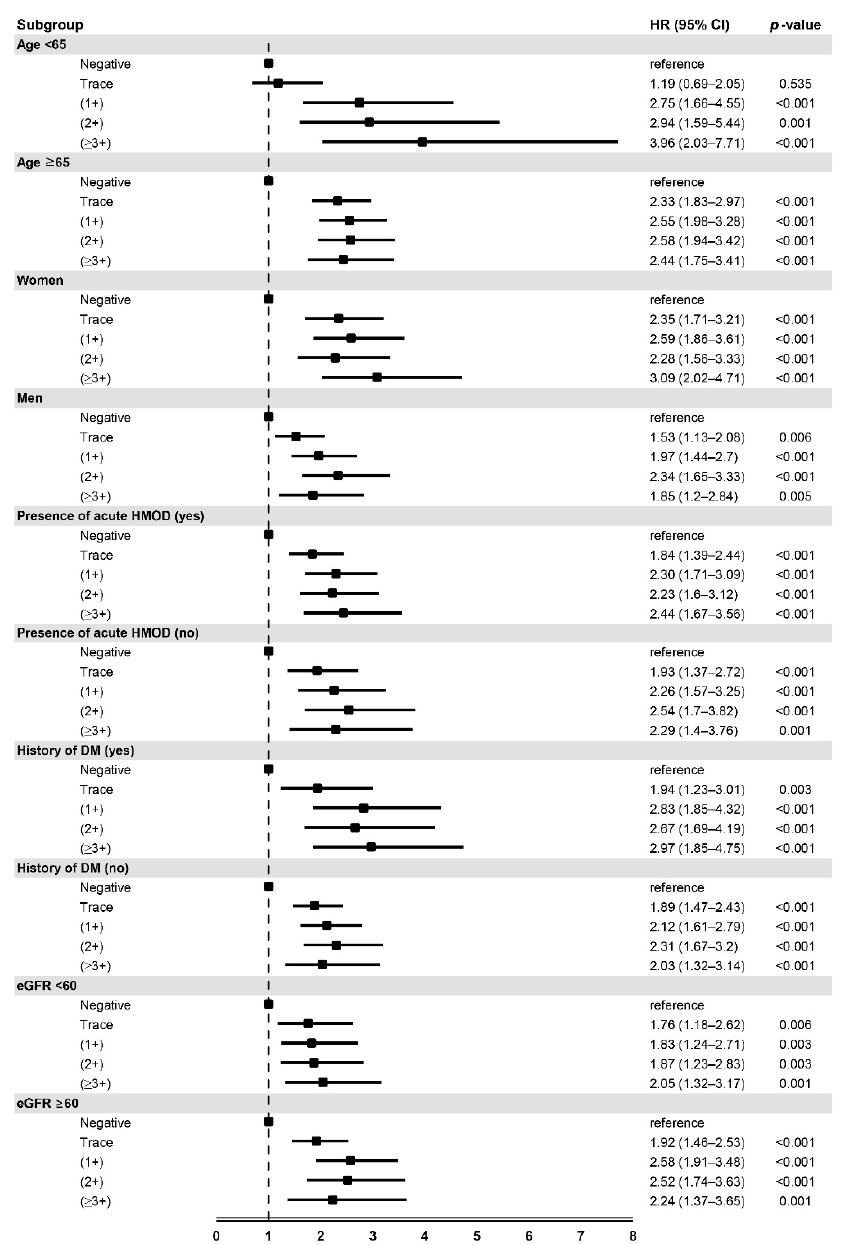
Figure 3. Adjusted hazard ratios of 3-year all-cause mortality according to the degree of dipstick proteinuria in subgroups. HR, hazard ratio; CI, confidence interval; HMOD, hypertension-mediated organ damage; DM, diabetes mellitus; eGFR, estimated glomerular filtration rate. Hazard ratios were adjusted by age, sex, systolic blood pressure, diastolic blood pressure, comorbidities (hypertension, diabetes mellitus, ischemic stroke, hemorrhagic stroke, and coronary artery disease), and components of HMOD (serum creatinine, cardiomegaly in chest radiography, and left ventricular hypertrophy in electrocardiography).